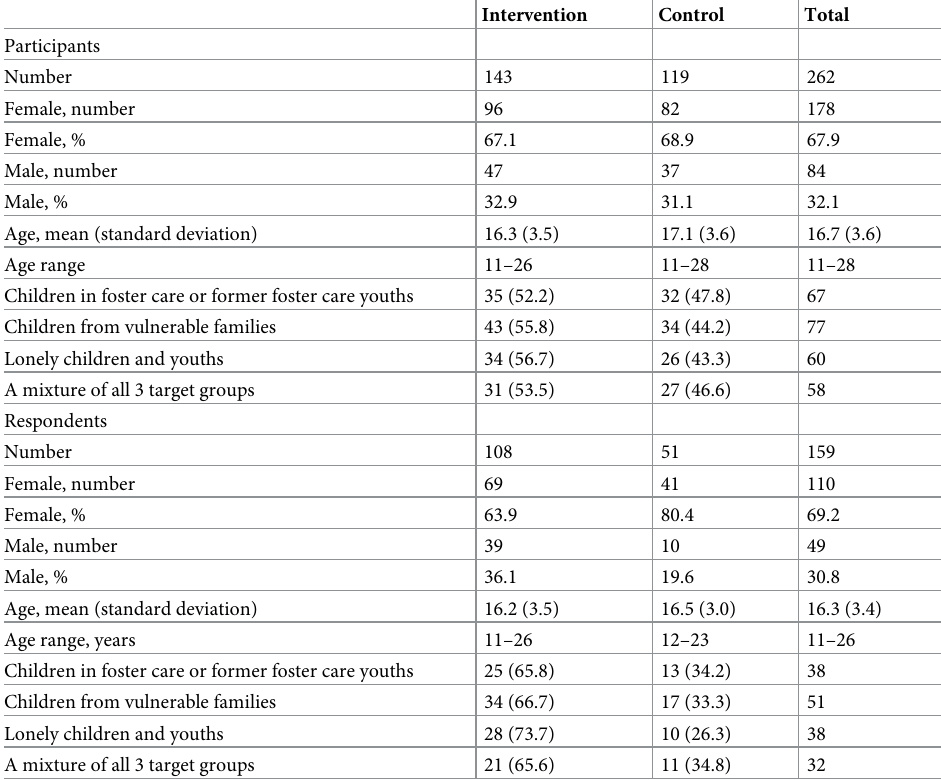
Table 1. Characteristics of the study population and respondents at follow-up.